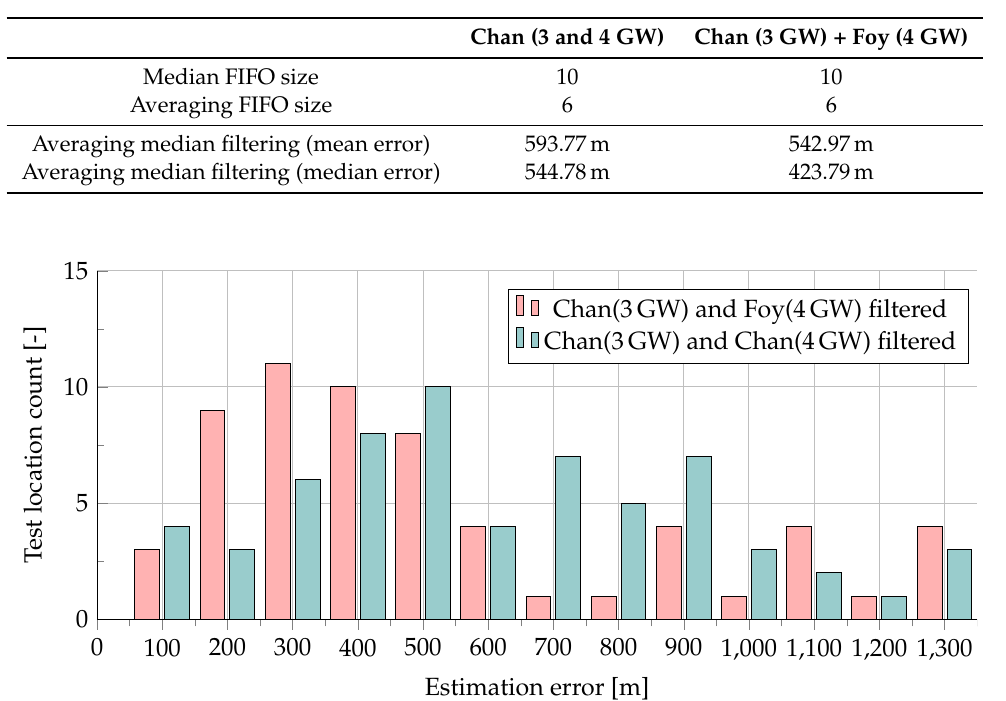
Table 4. Comparison of precision using different combinations of geolocation algorithms with post-filtering.